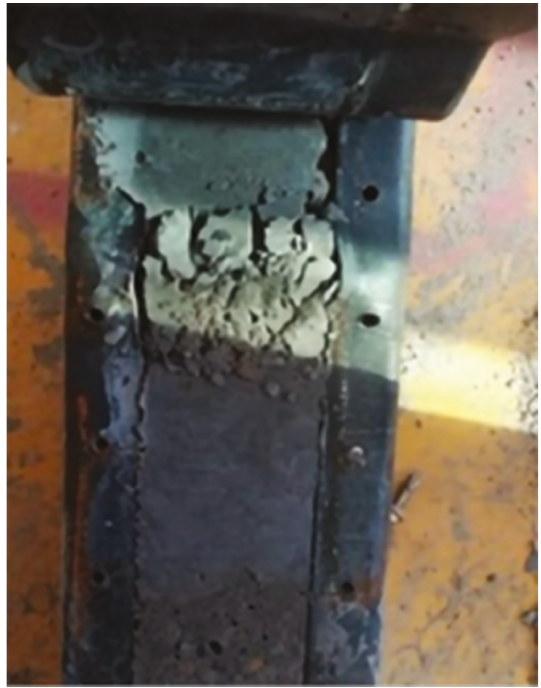
Figure 8: Inner concrete crushed close to the buckling wall.